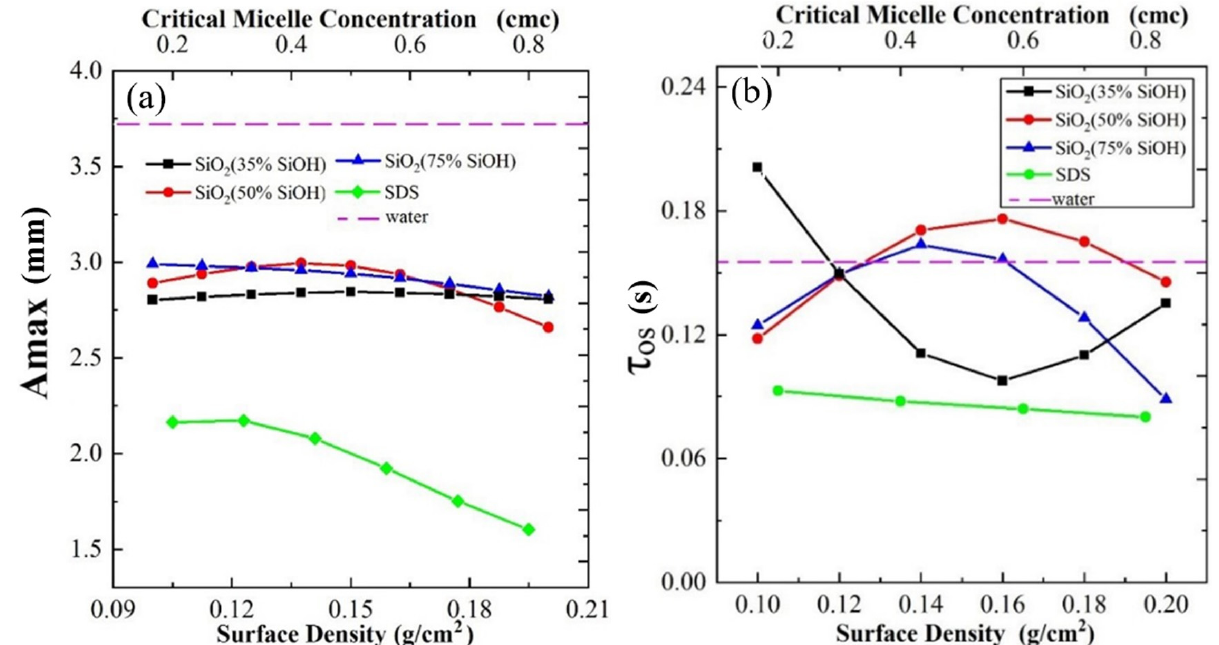
Figure 6. ( a ) The maximum amplitude of waves at the surface when bubbles impact with the gas- liquid interface; ( b ) the oscillation time. gas-liquid interface; ( b ) the oscillation